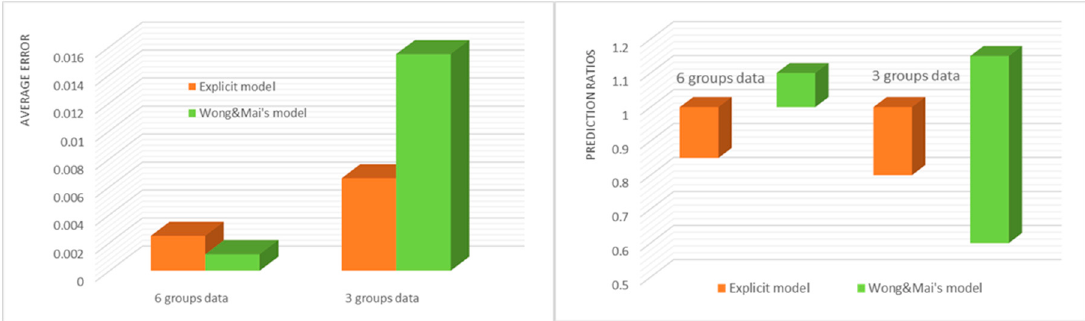
Figure 12. Average error and prediction ratios regarding the empirical-data number.